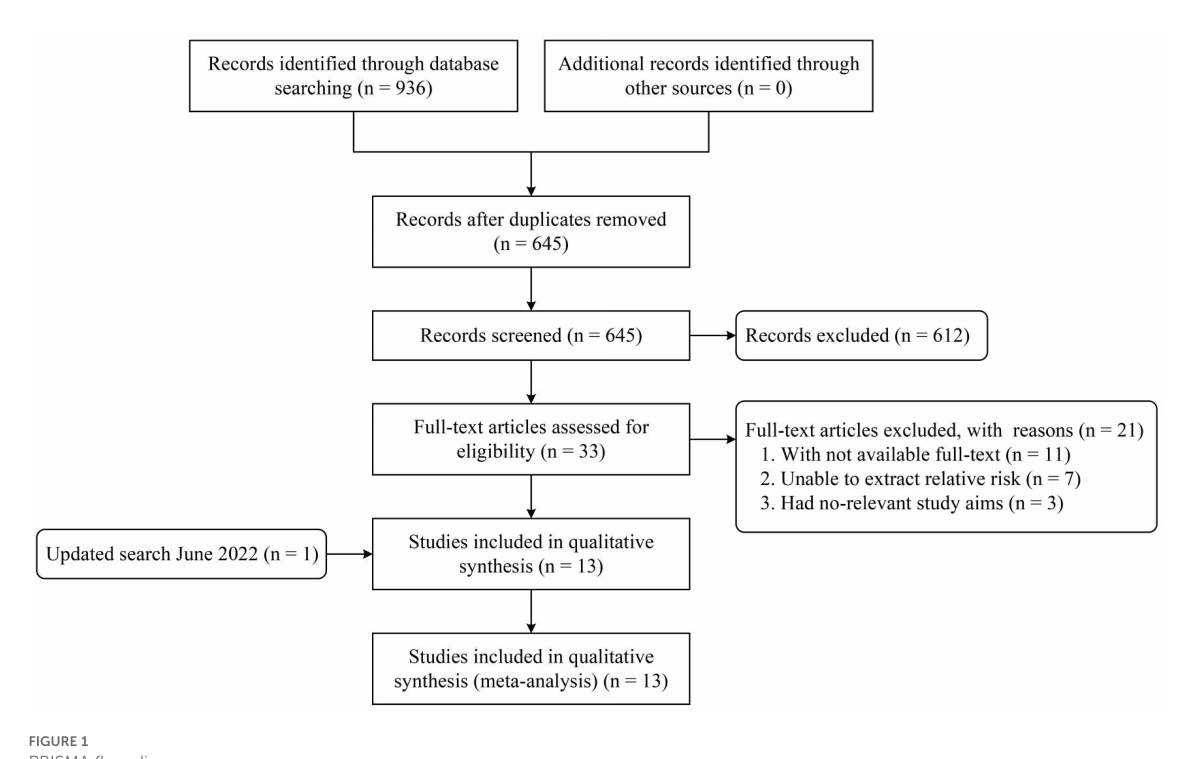
FIGURE1 PRISMA flow